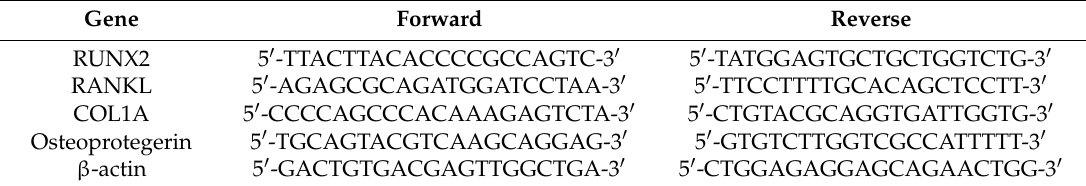
Table 1. Real time-PCR primer